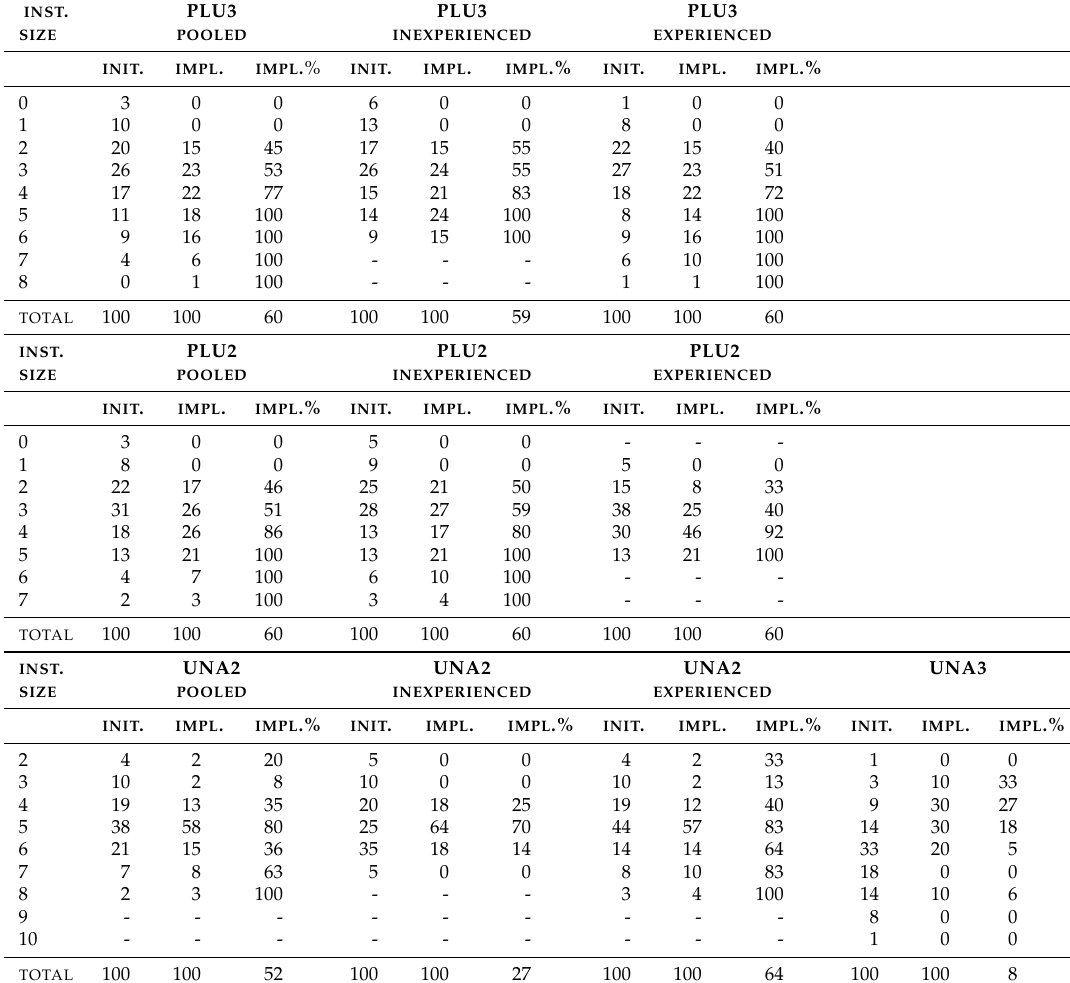
Table 6. Relative frequency initiation and implementation, and implementation rate by institution size. INST . PLU3 PLU3 PLU3 SIZE POOLED INEXPERIENCED EXPERIENCED INIT . IMPL . IMPL . % INIT . IMPL . IMPL .% INIT . IMPL . IMPL .% 0